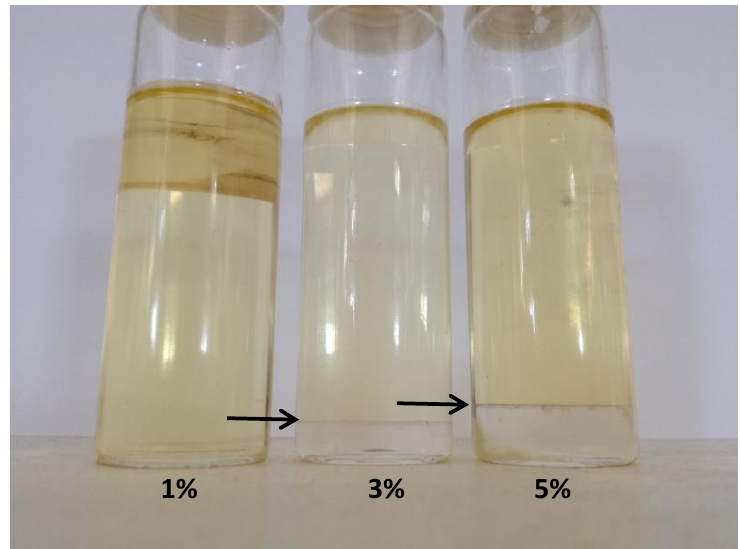
Figure 5. Final reaction mixtures were obtained using an increasing amount of AlCl 3 ∙6H 2 O in catalysis. Reaction conditions: molar ratio ethanol:LA = 1; AlCl 3 ∙6H 2 O from 1 to 5%mol, temperature = 343 K, time = 8 h. When 1% of AlCl 3 ·6H 2 O was used in catalysis, the reacted mixture appeared as a homogenous system, whereas when AlCl 3 ·6H 2 O was 3 or 5% with respect to LA a bi- phasic system was eventually obtained (the arrows indicate the separation of phases). The upper yellowish part is the organic fraction, whereas the uncolored part on the bot- tom was the aqueous phase. Reaction mixtures obtained by the use of 3 and 5% AlCl 3 ·6H 2 O were separated into upper organic and bottom aqueous phases and thoroughly analyzed. Details on their composition were reported in Table 3. Table 3. Compositions of organic and aqueous phases were obtained by using 3 and 5% AlCl 3 ·6H 2 O in direct esterification .